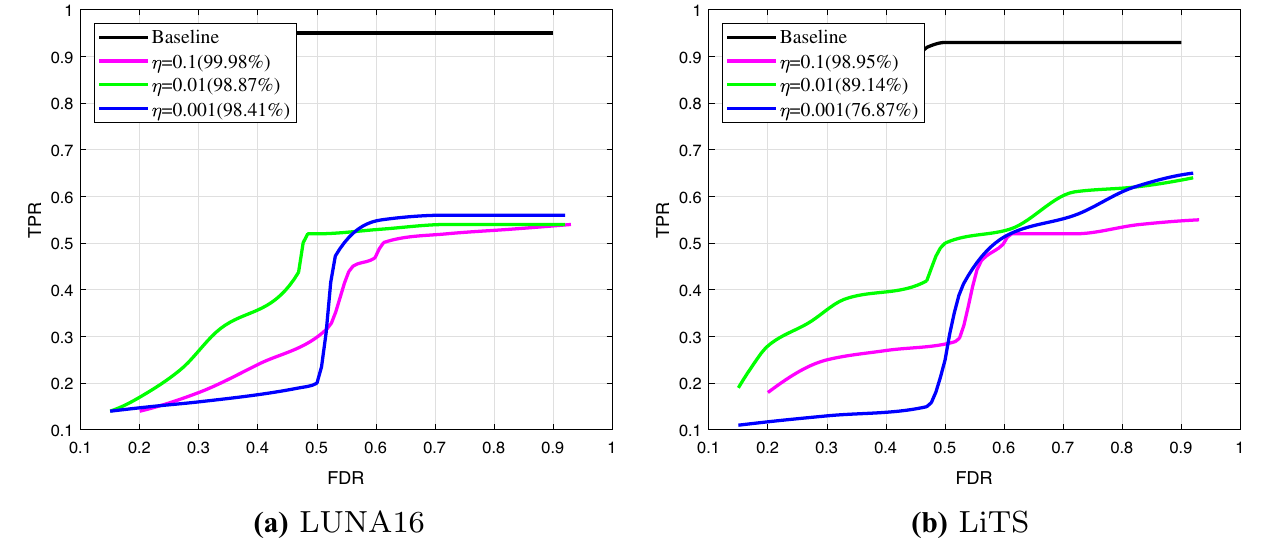
old. The uncertainty threshold used to generate a particular color’s curve is the same across plots in different